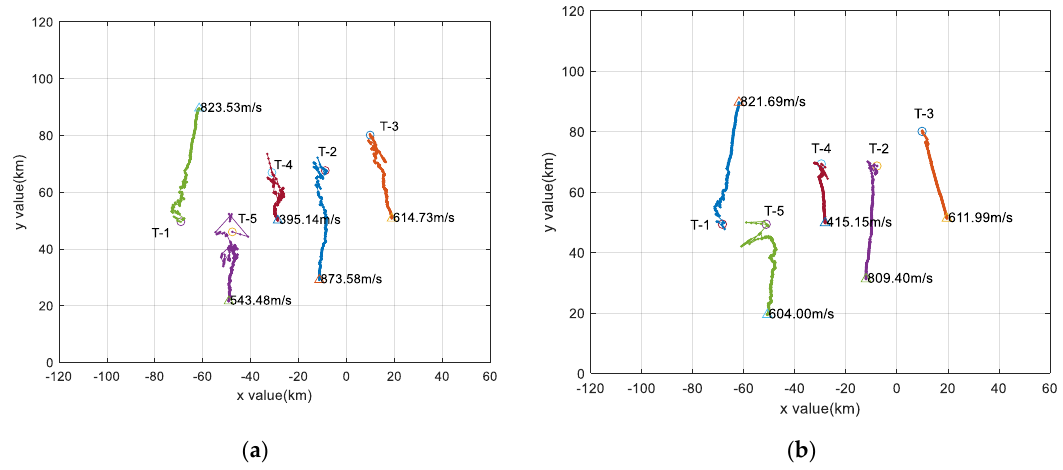
Figure 12. Valid tracing results comparison of both algorithms: ( a ) SNN-Kalman tracing result; ( b ) MCSNG-SNN-K tracing result. Table 5. The comparison of five targets tracing results between SNN-Kalman and MCSNG-SNN-K. Mean Trace Error (m) Track NO.